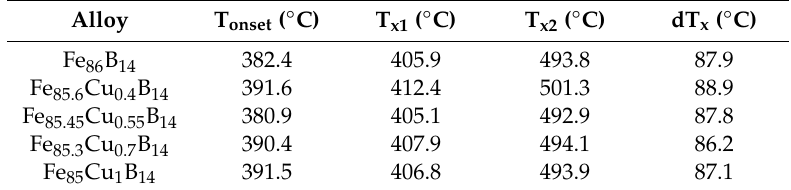
Table 1. The characteristic temperatures of crystallization at heating rate 20 ◦ C / min.